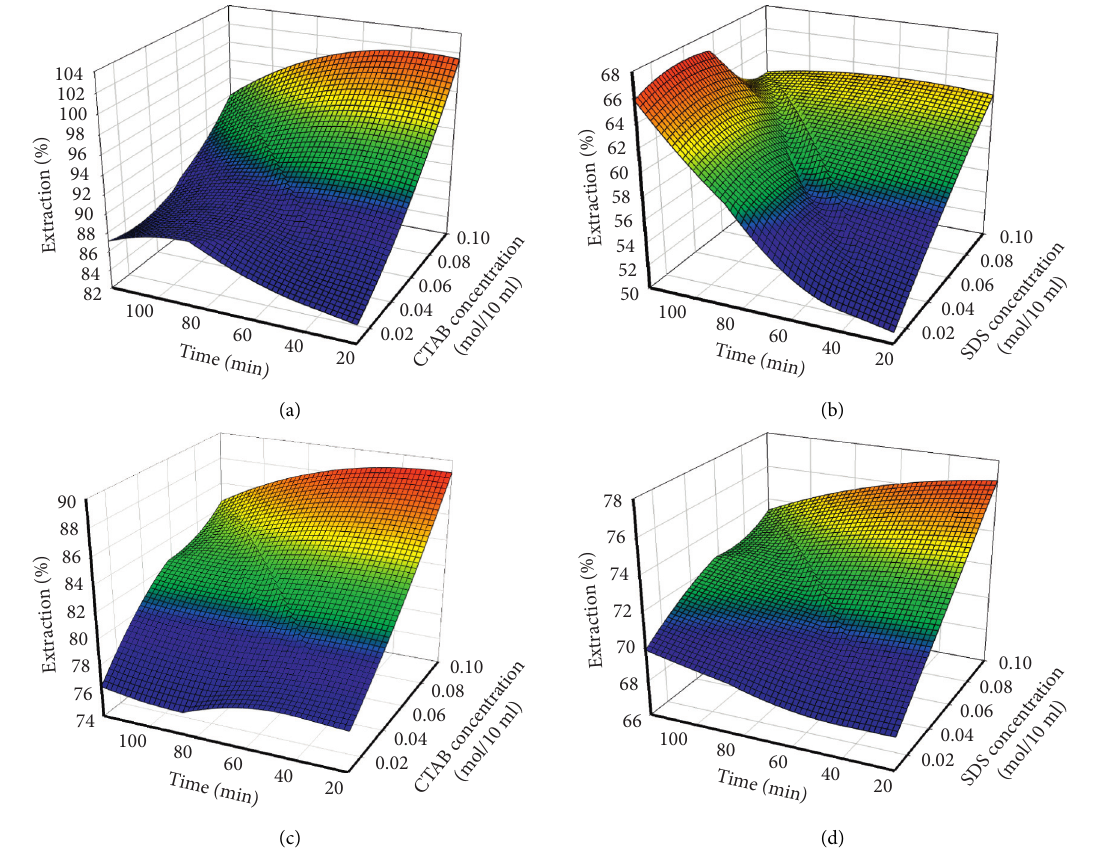
Figure 10: 3D plots of the interaction influence of the contact of time and surfactants concentration on the extraction% of RY145 by (a) CTAB and (b) SDS and RB222 by (c) CTAB and (d) SDS.